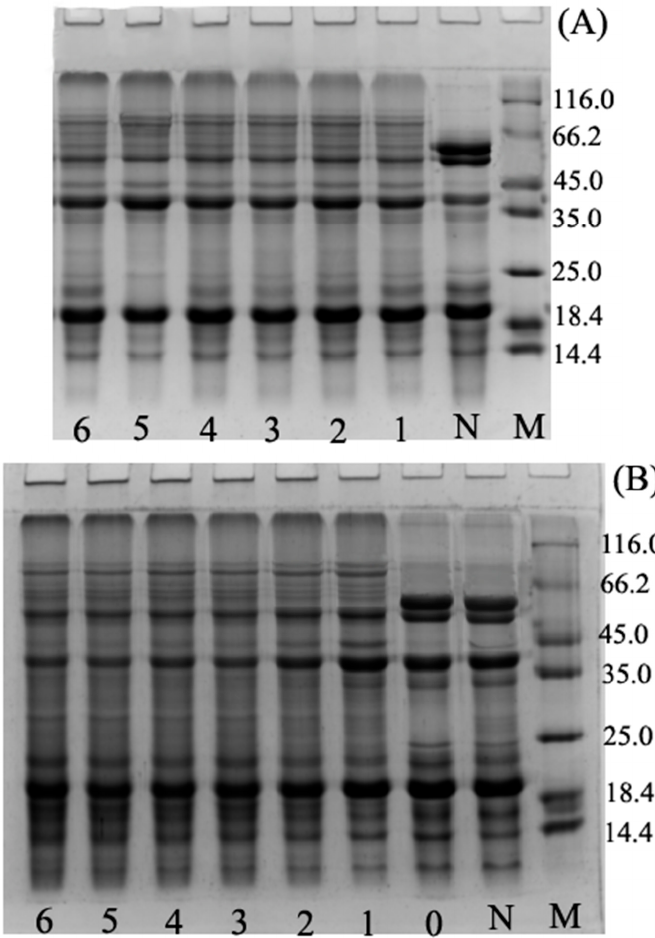
Figure 1. SDS-PAGE profiles of BBPI by wet heating ( A ) and ultrasound treatment Maillard reaction ( B ). Lane M: maker, lane N: native BBPI, lane 0: BBPI of ultrasound treatment, lanes 1–6: wet Maillard reaction ( A ) and ultrasound treatment Maillard reaction ( B ) for 1–6 h, respectively. The concentration of protein solution in each lane of the gels was 5 mg /